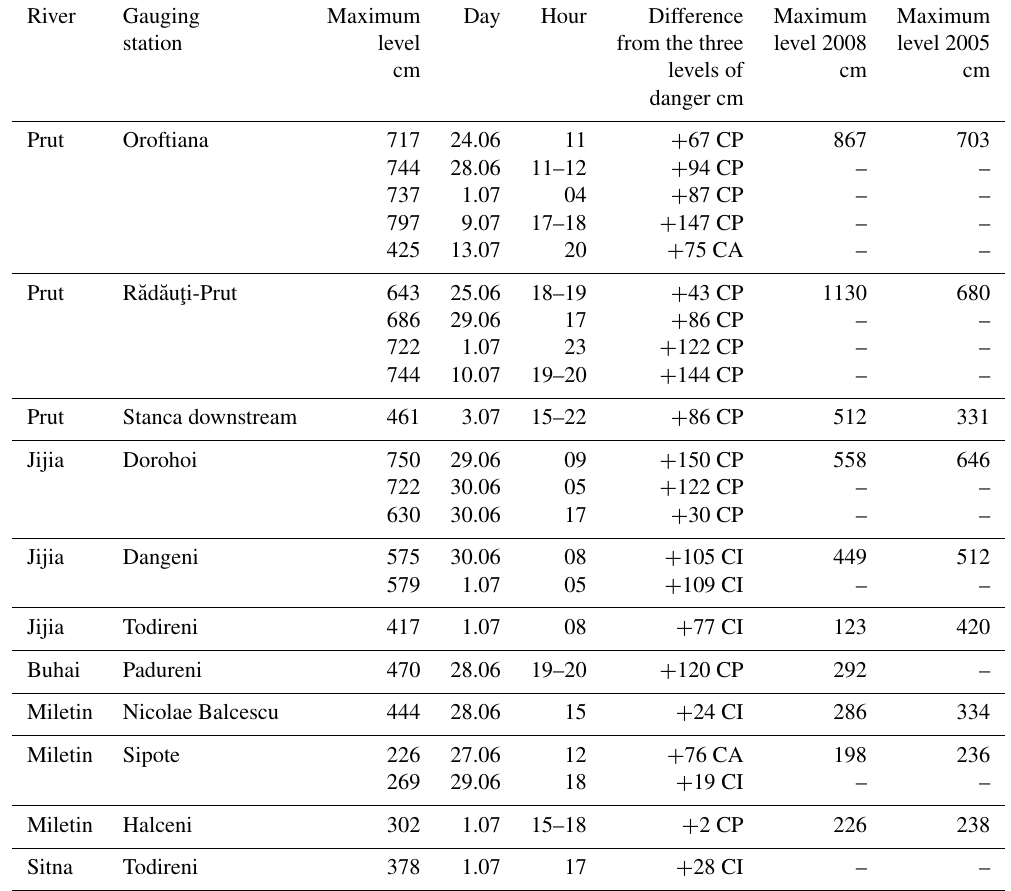
Table 6. Maximum water levels during flooding in the summer of 2010 compared to 2008 and